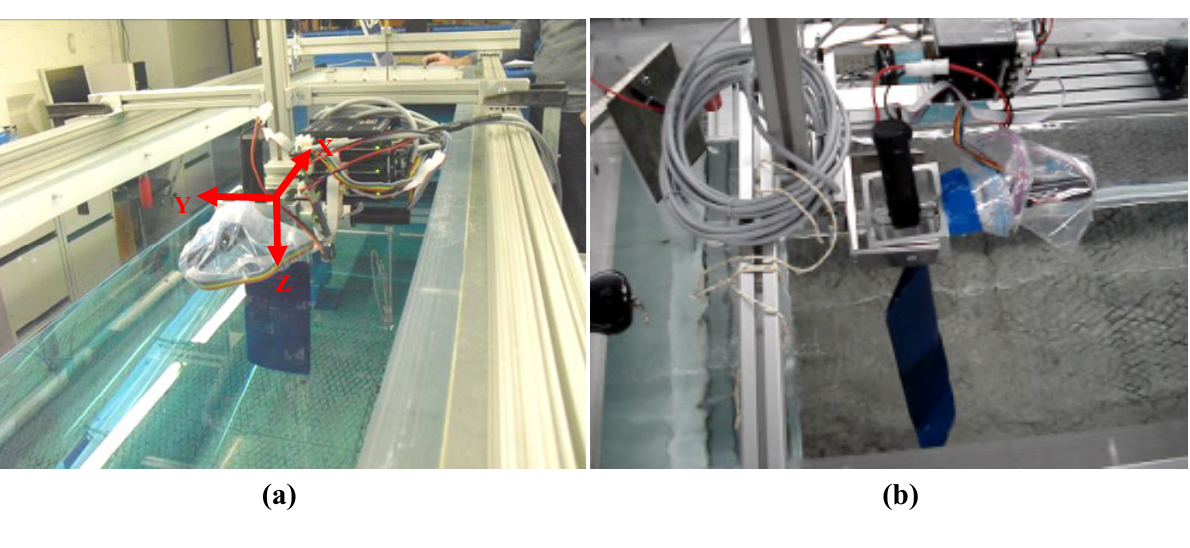
Figure 10. (a) Water channel with the reference axis system. (b) Water channel facility during an